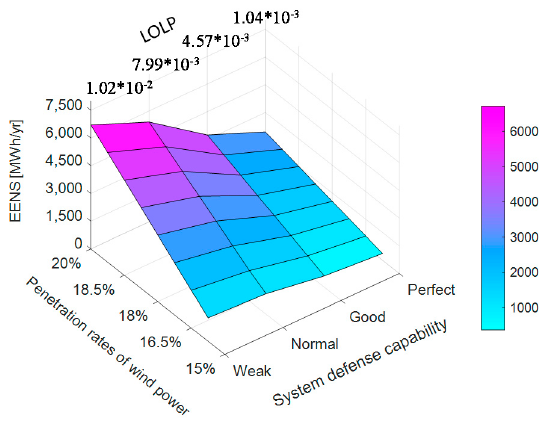
Figure 7. Reliability performances of systems with different defense capabilities.